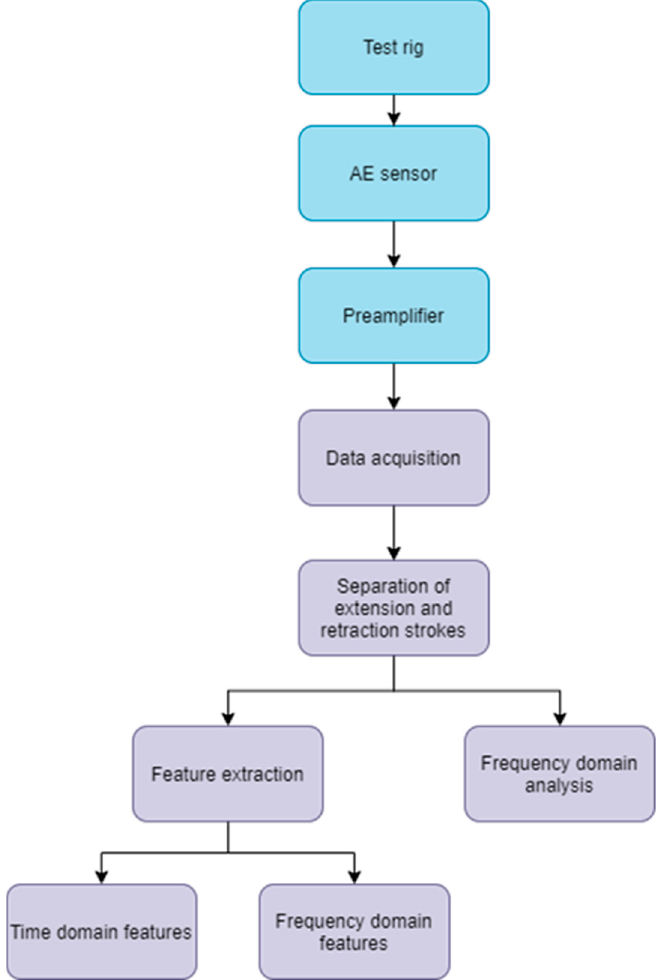
Figure 2. Sensor locations: ( a ) on rod (sensor mounted and secured with tape); ( b ) sensor location on the upper flange.